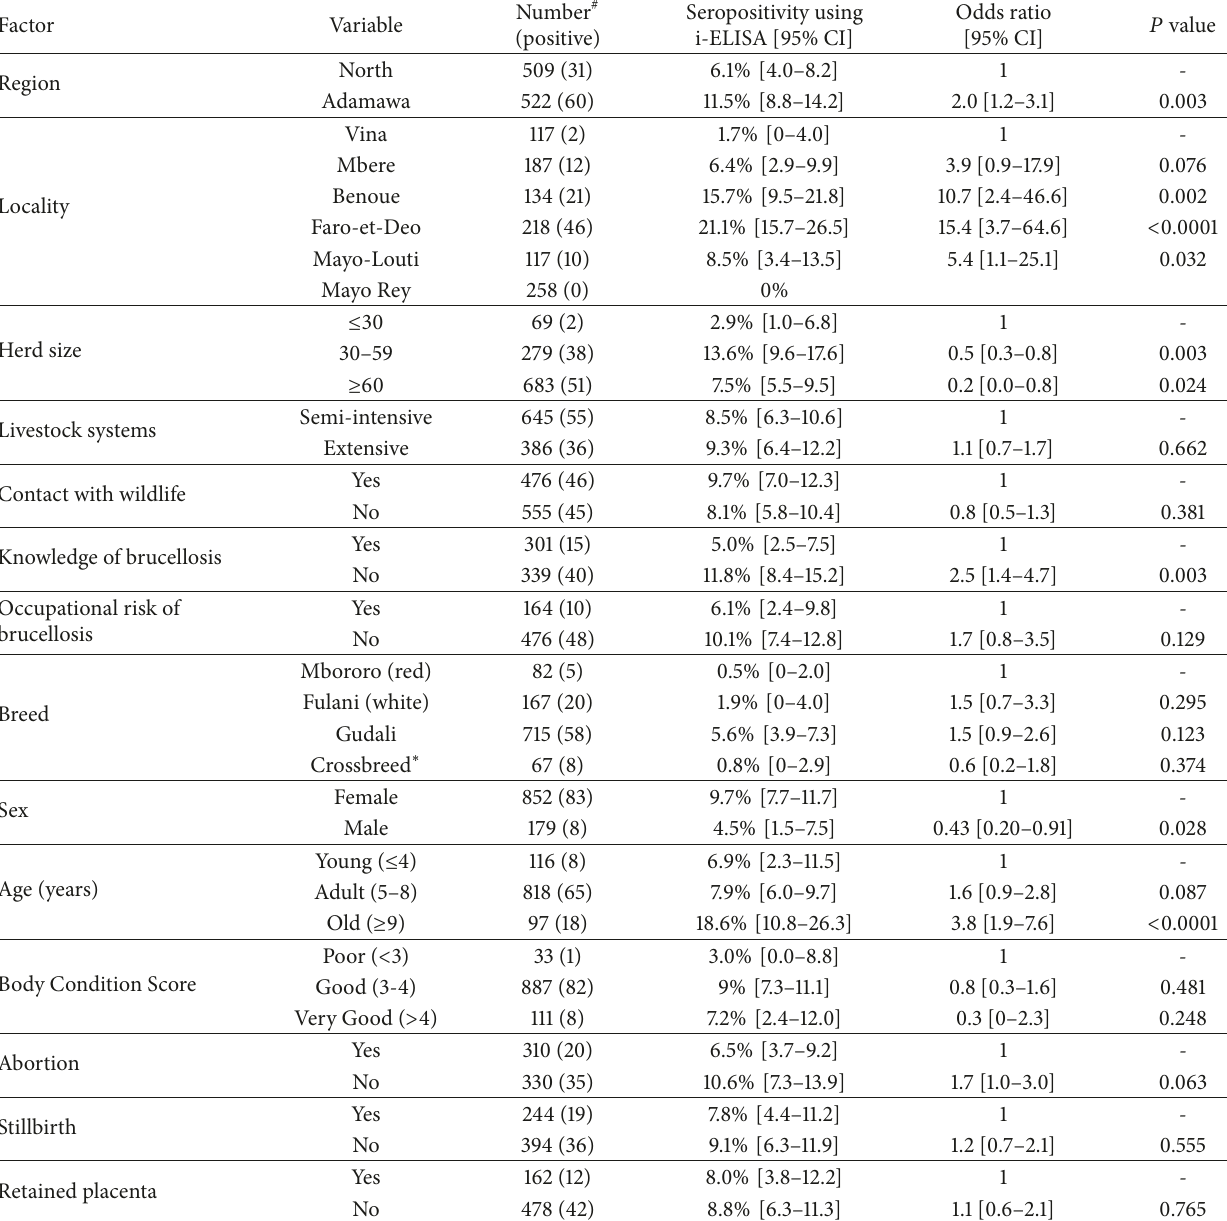
Table 2: Risk factor model for brucellosis seropositivity in individual cattle in Adamawa and North Regions of Cameroon ( 𝑛 = 1031